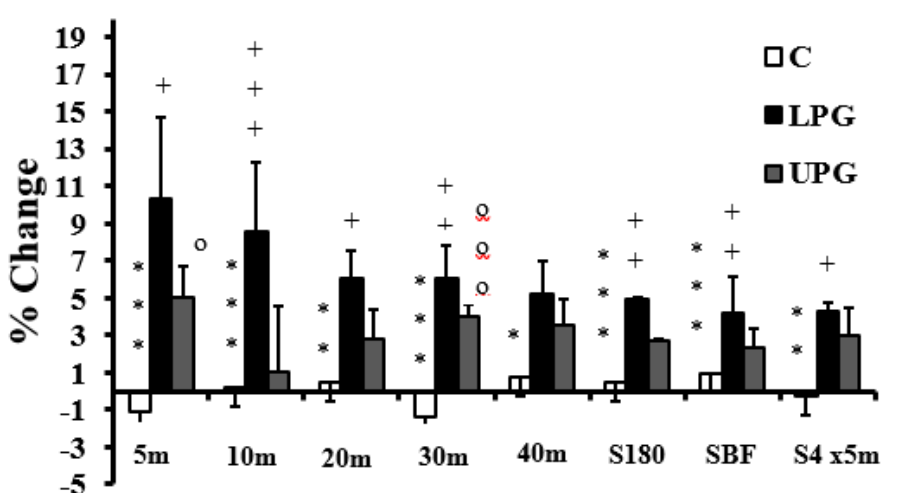
Figure 5. Training associated changes in sprint performance and ability to change direction in loaded plyometric group (LPG), unloaded plyometric group (UPG) and controls (C). S180° = sprint time over 9–3–6–3–9 m with 180° turns; SBF = sprint time over 9–3–6–3–9 m with backward and forward running; S4 × 5 = sprint time over 4 × 5 m; * = denotes a significant difference between LPG and C; + = denotes a significant difference between LPG and PG; o = denotes a significant difference between UPG and C; *: p < 0.05; **: p < 0.01; ***: p < 0.001; +: p < 0.05; ++: p < 0.01; +++: p < 0.001; o: p < 0.05; ooo: p < 0.001.